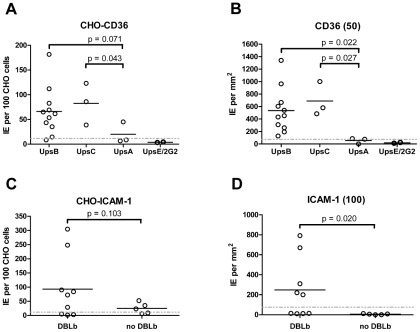
Infected erythrocyte binding to CD36 and ICAM-1.Dot plots show averaged results of replicate infected erythrocyte binding
experiments for individual cloned parasites lines contained in the panel
(Figure 5) and
grouped either by (A, B) Ups classification of major
var transcript or (C, D) presence of DBLβ
adhesion domain in the major var transcript. Mean
infected erythrocyte binding was compared between groups using
non-paired, 1-tailed t-tests. P-values are indicated according to the
95% confidence interval. An arbitrary threshold for positive
binding (grey dashed line) was calculated as the mean level of infected
erythrocyte binding plus two standard deviations either to untransfected
CHO745 cells or to spots containing 2% bovine serum albumin,
respectively. (A) Infected erythrocyte binding to
CHO745-CD36. (B) Infected erythrocyte binding to
recombinant CD36-Fc fusion protein immobilized in 10 µL spots at
50 µg/mL onto polystyrene substrate. (C) Infected
erythrocyte binding to CHO745-ICAM-1. (D) Infected
erythrocyte binding to recombinant ICAM-1-Fc fusion protein immobilized
in 10 µL spots at 100 µg/mL onto polystyrene substrate.